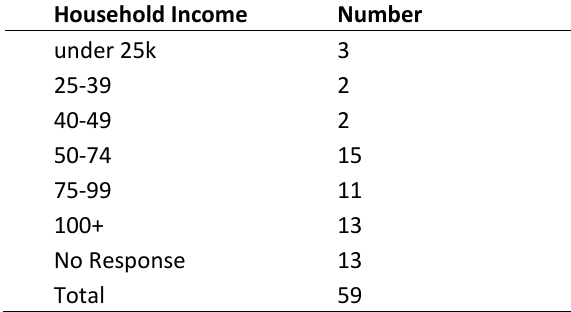
Table 3. Total household income.